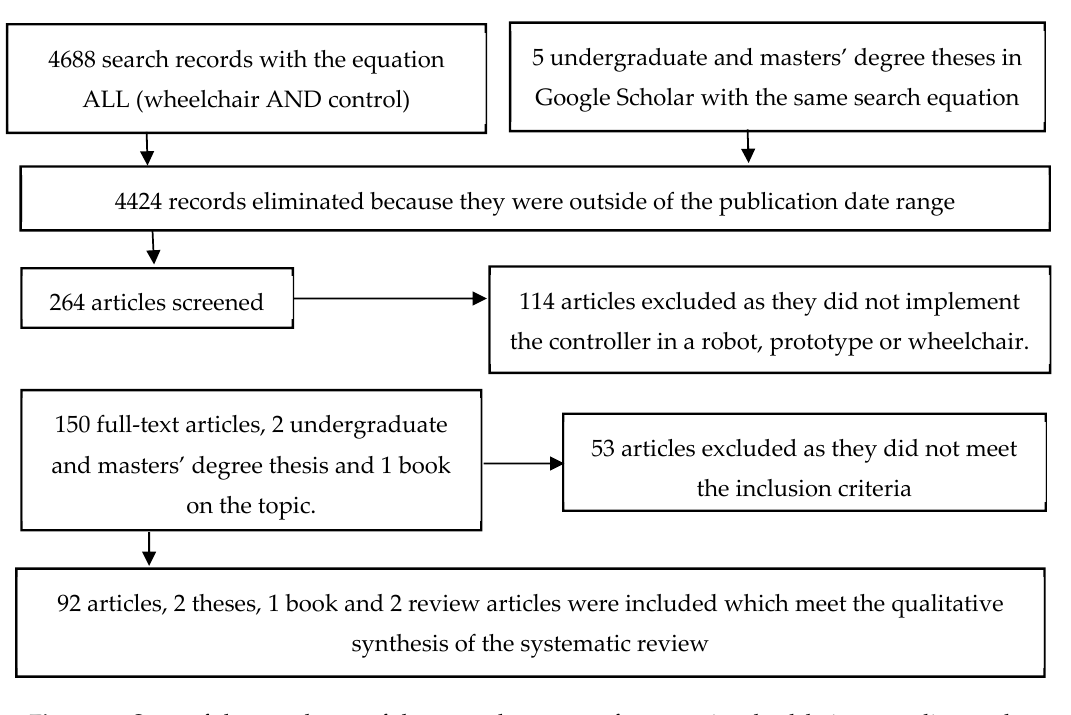
Figure 1. State-of-the-art phases of the control systems of automatic wheelchairs according to the PRISMA format.